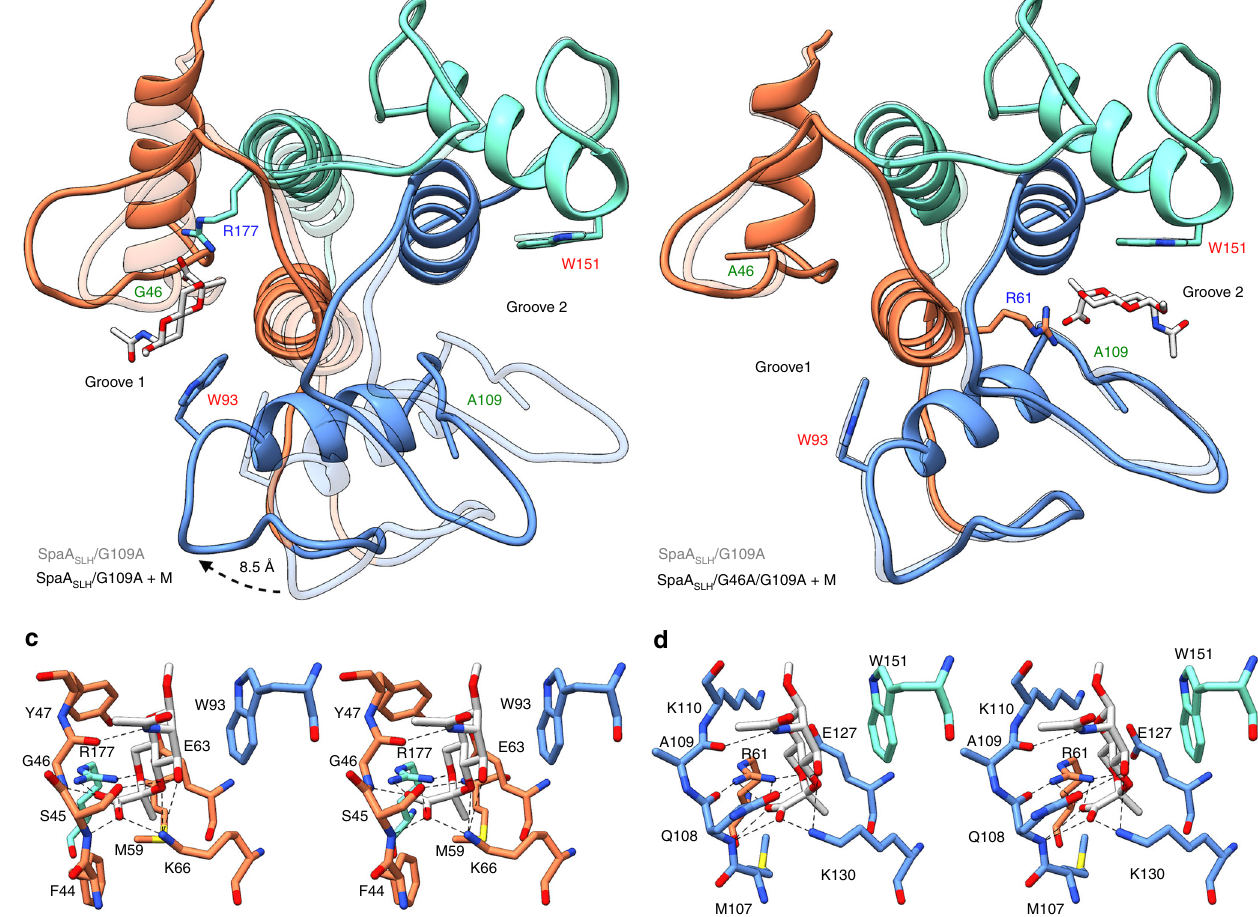
Fig. 5 SpaA SLH /G109A ligand binding and conformational change. Ribbon diagrams of a SpaA SLH /G109A with bound monosaccharide overlayed with unliganded SpaA SLH /G109A (transparent), and b SpaA SLH /G46A/G109A with bound monosaccharide overlayed with unliganded SpaA SLH /G109A (transparent). Alignments were performed using the helices of SLH3. Stereo views of monosaccharide binding in G1 of SpaA SLH /G109A and G2 of SpaA SLH /G46A/G109A are shown in c and